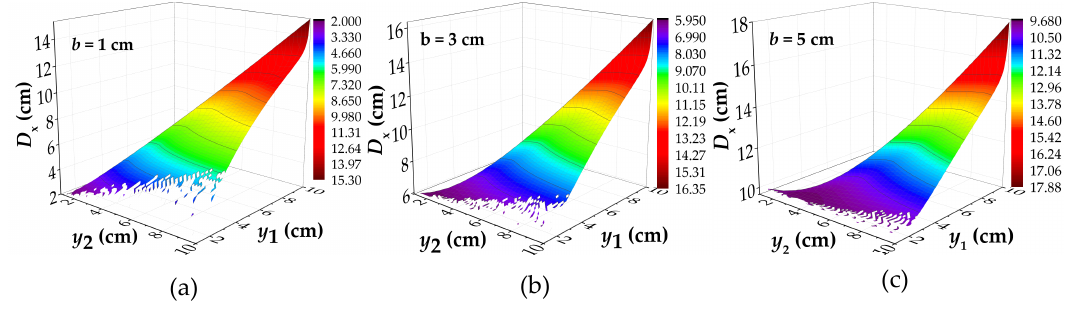
Figure 5. The calculated results of D x under the di ff erent values of b : ( a ) the calculated results of D x under b = 1 cm; ( b ) the calculated results of D x under b = 3 cm; ( c ) the calculated results of D x under b = 5 cm; D x : the intersecting point distance between curves of magnetic flux component of x direction at di ff erent lift o ff heights; y 1 and y 2 : the lift o ff height; b : the half of corrosion width.